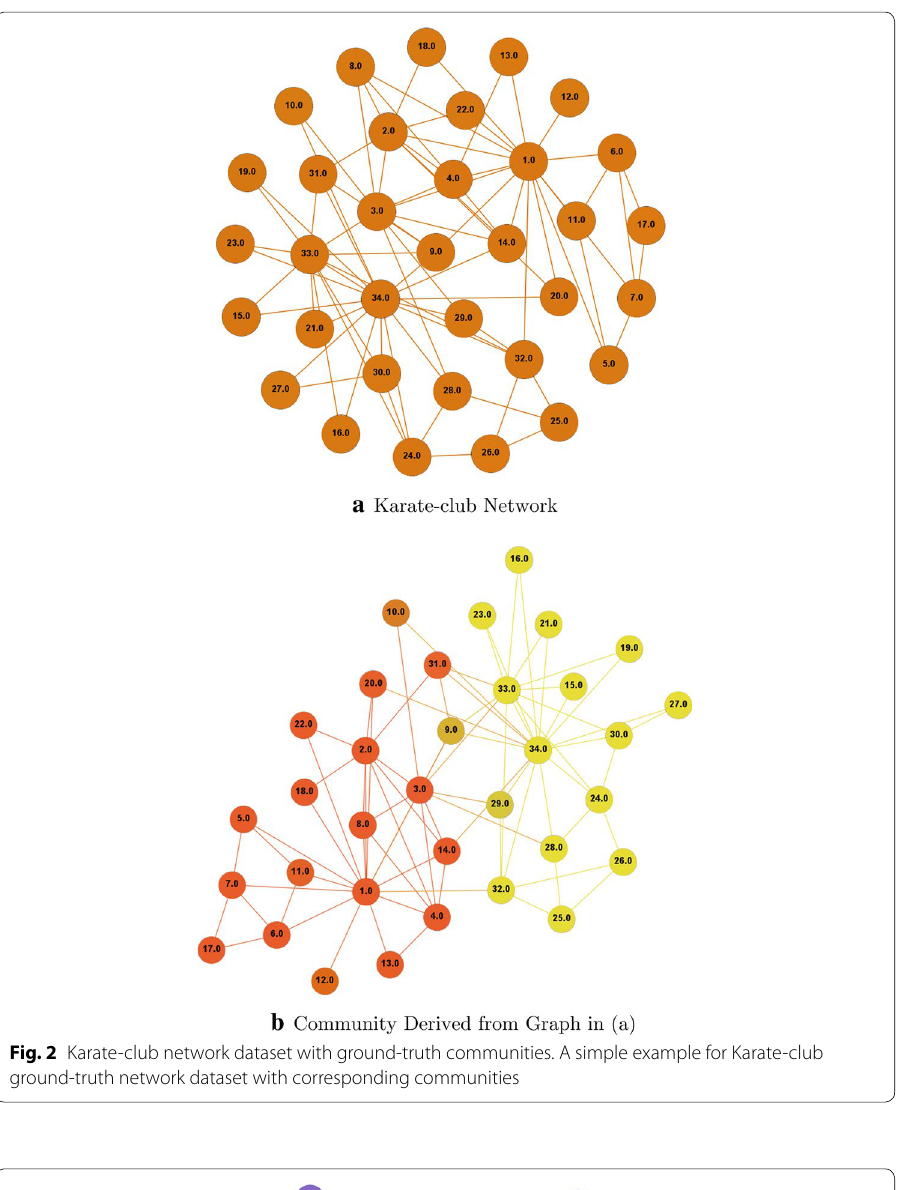
Fig. 2 Karate-club network dataset with ground-truth communities. A simple example for Karate-club ground-truth network dataset with corresponding communities